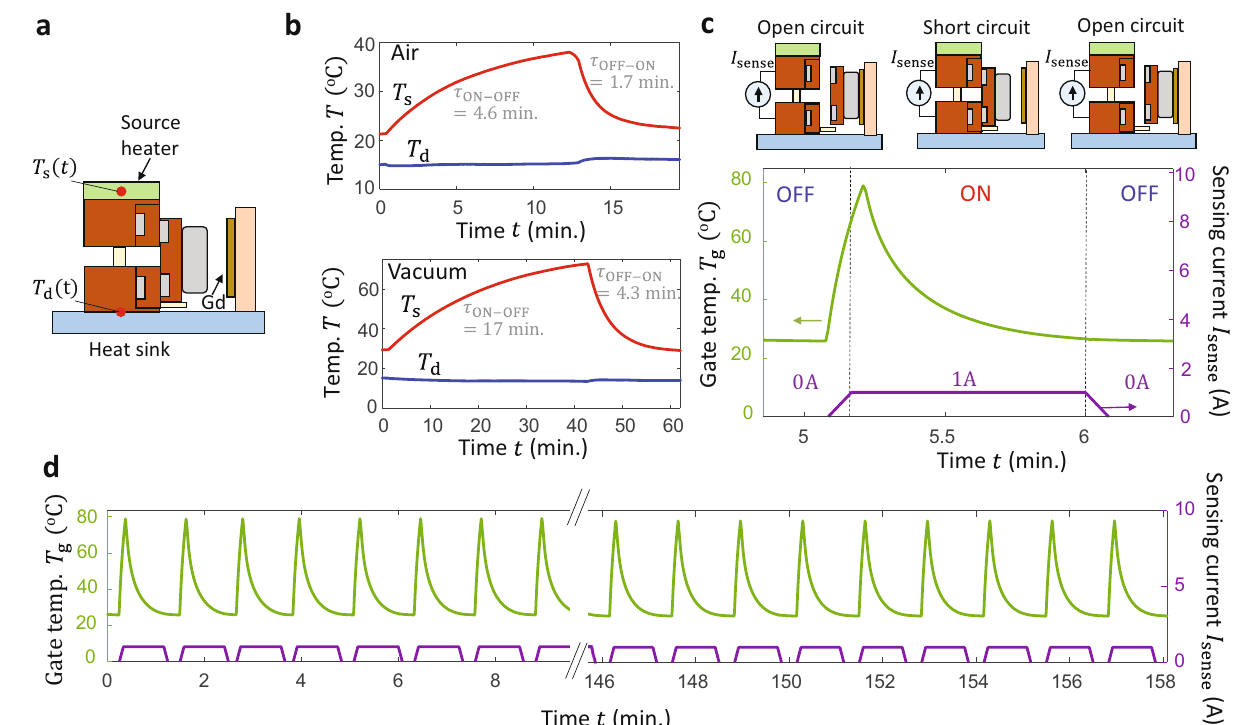
Fig. 4 | Transient transistor response and cycling. a To quantify the time response of the transistor, we apply a constant heating power to a source heater and record T s ð t Þ and T d ð t Þ after switching the transistor state via T g . b The char- acteristictransistorthermaltimeconstantsrangefrom1.7to4.6mininair(top)and